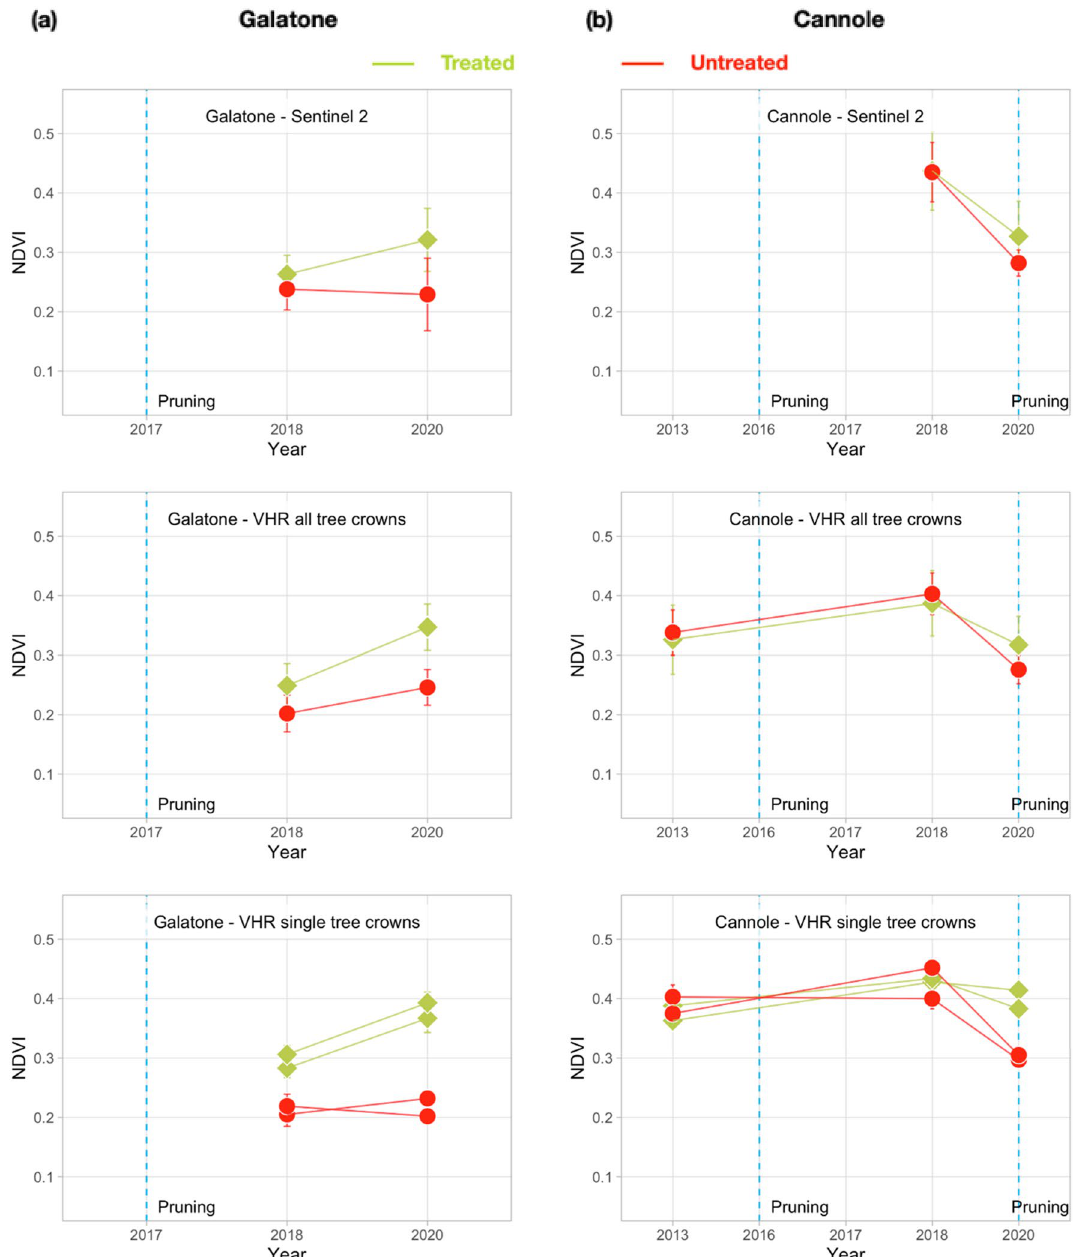
Figure 12. NDVI mean value for Galatone (Ionian coast, column a ) and Cannole (Adriatic coast, column b ) from: all S-2 pixels in the field (the first line); only all Pléiades tree crown pixels in the fields (second line); Pléiades tree crown pixels of different sample trees (third